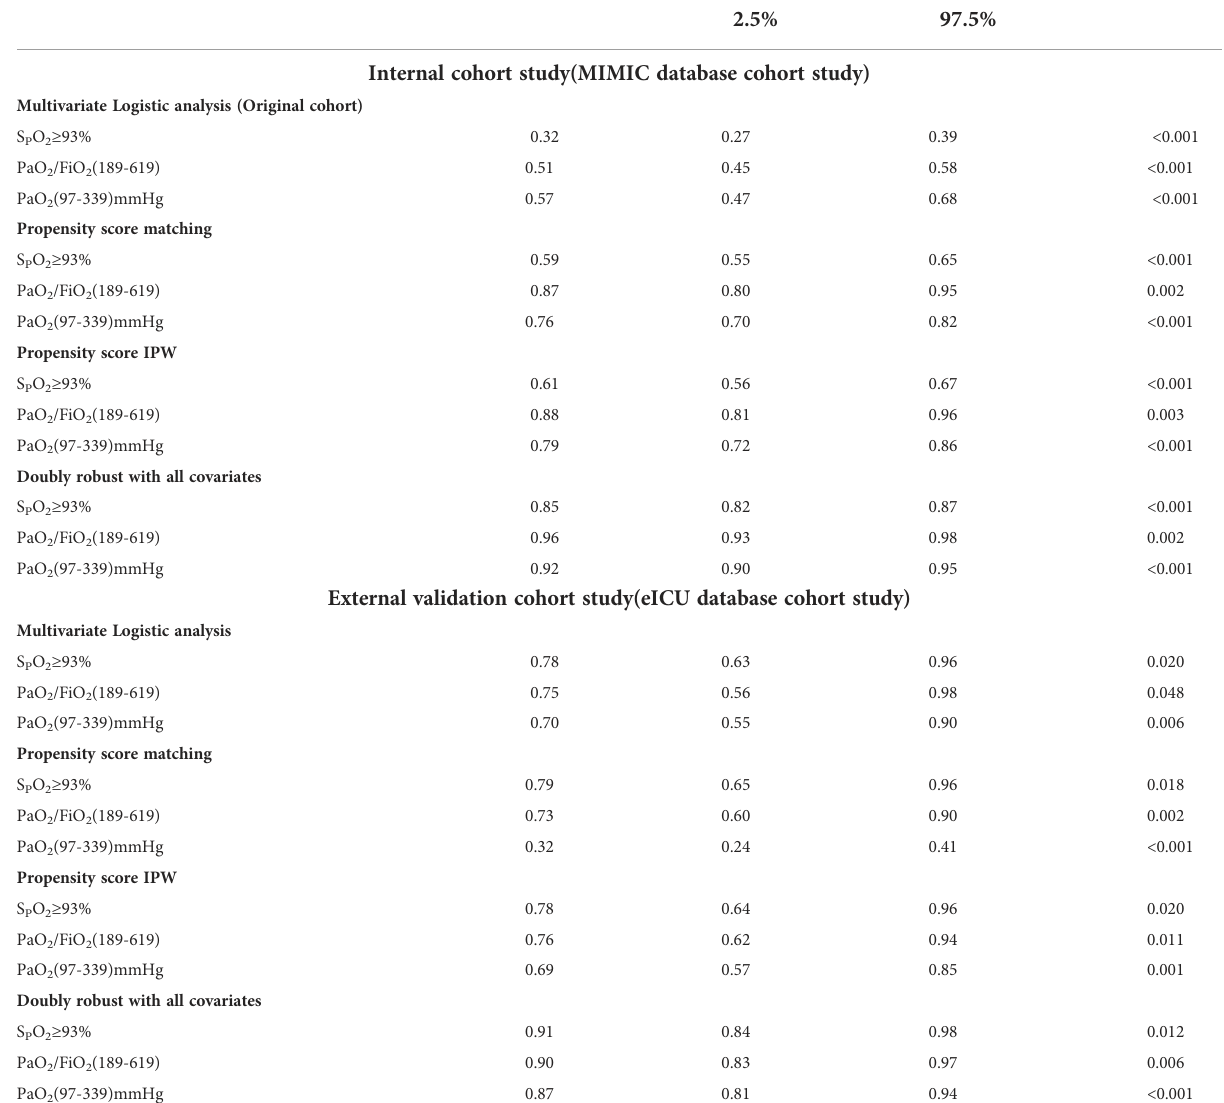
TABLE 2 Multiple models analysis of blood oxygen index to incidence in sepsis with encephalopathy.